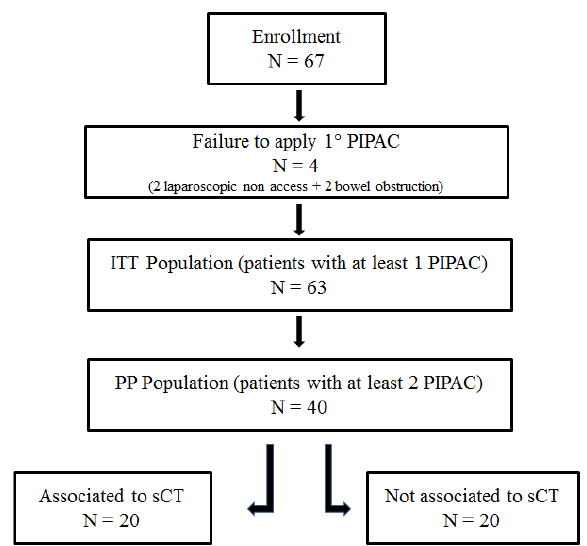
Figure 1. Diagram of patients' flow through the study.